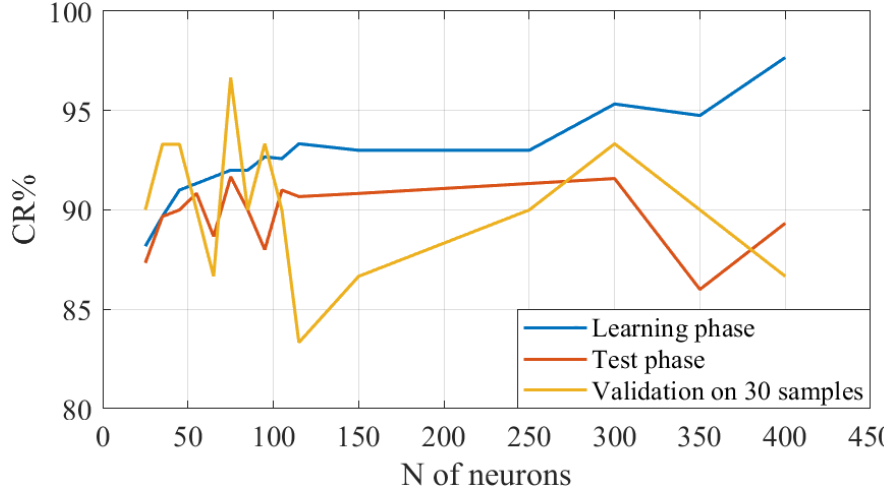
Figure 11. Classification rate with respect to the number of neurons in the hidden layer.